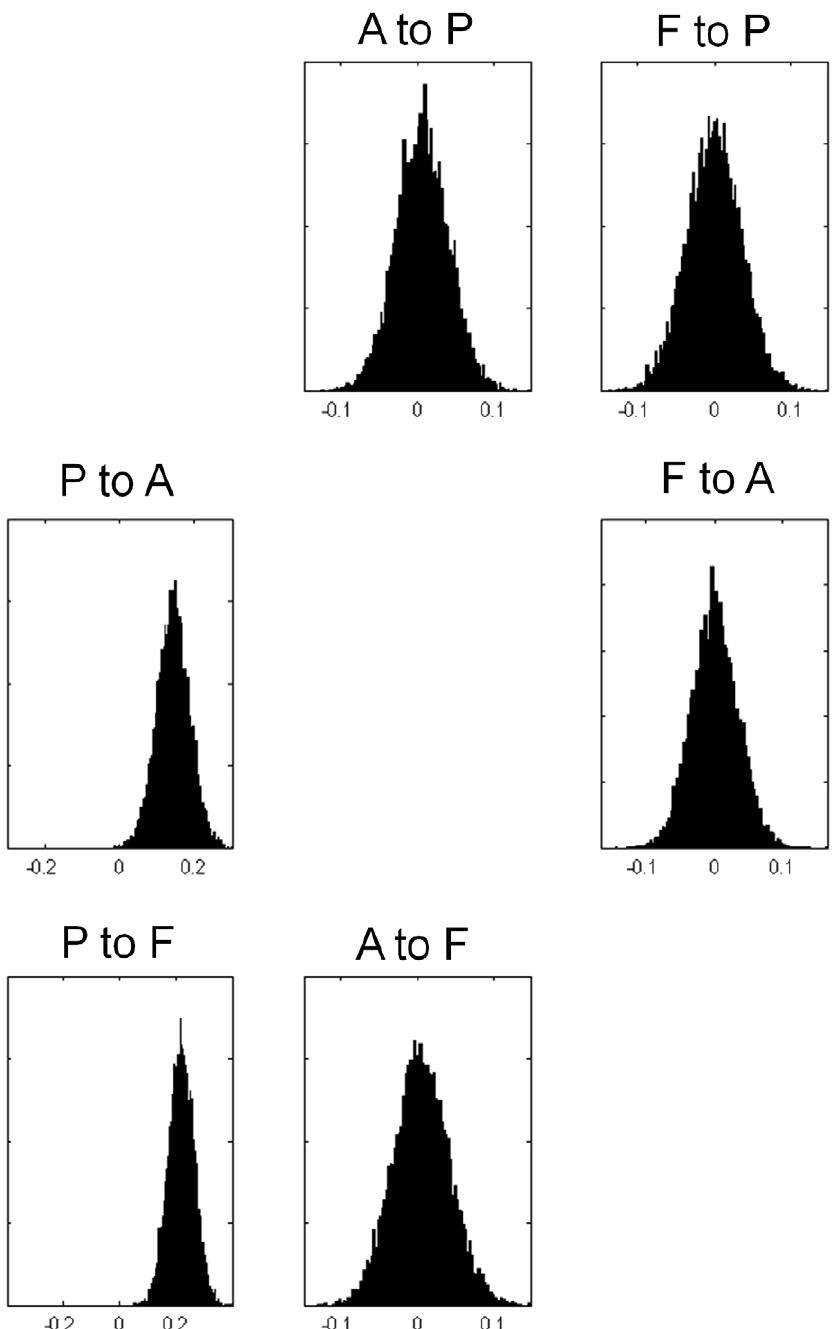
Figure 8. Average Modulatory Connections from RFX for input family P. The figures show the posterior densities of average network parameters from random effects Bayesian model averaging for the modulatory connections. Only forward connections from P to A and from P to F are modulated by speech intelligibility.